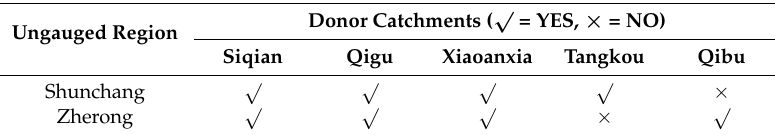
Table 5. Donor catchments for ungauged